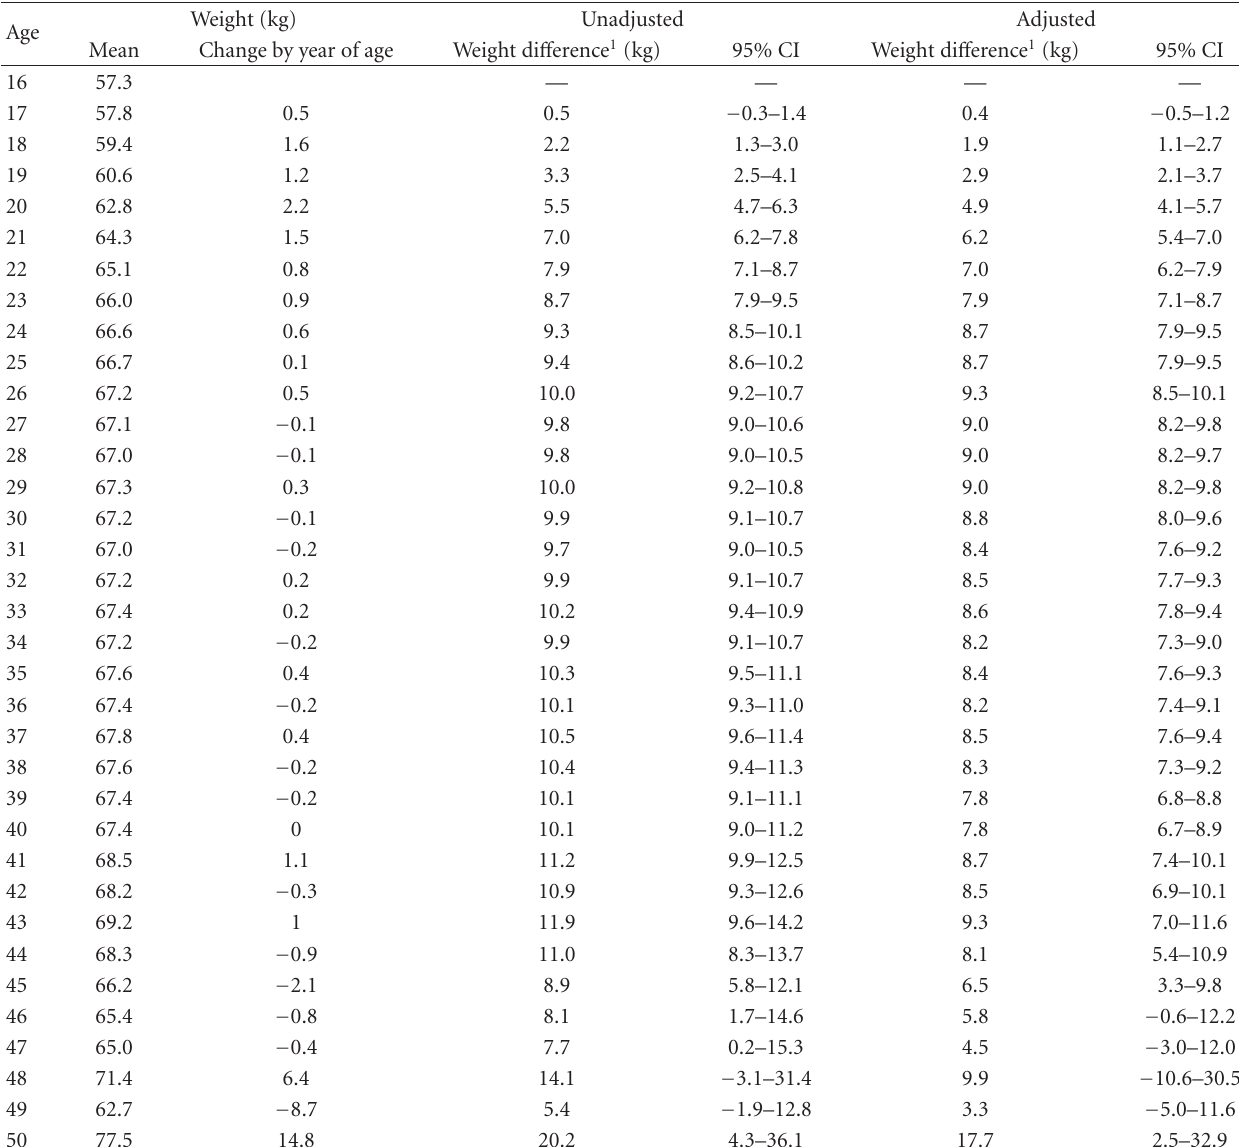
Table 2: Change in maternal prepregnancy bodyweight (kg) compared to the reference weight by year of age, unadjusted and adjusted for parity and year of child’s